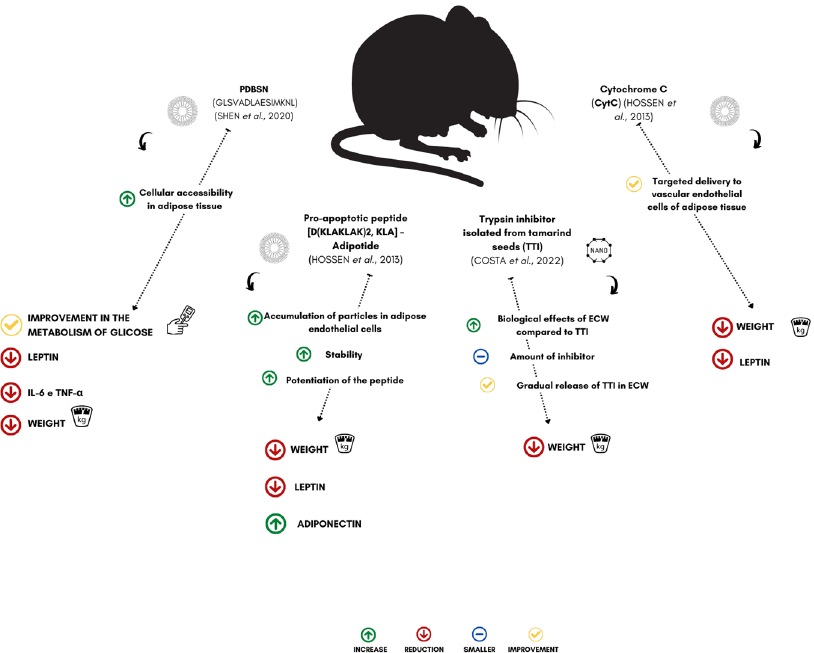
Figure 3. Effect of encapsulated peptides and proteins on weight loss in experimental models. PDBSN (peptide GLSVADLAESIMKNL), KLA-Adipotide (pro-apoptotic peptide (D(KLAKLAK)2), TTI (trypsin inhibitor isolated from tamarind seeds), CytC (cytochrome C), IL-6 (interleukin-6), and TNF- α (tumor necrosis factor alpha) [29–32].